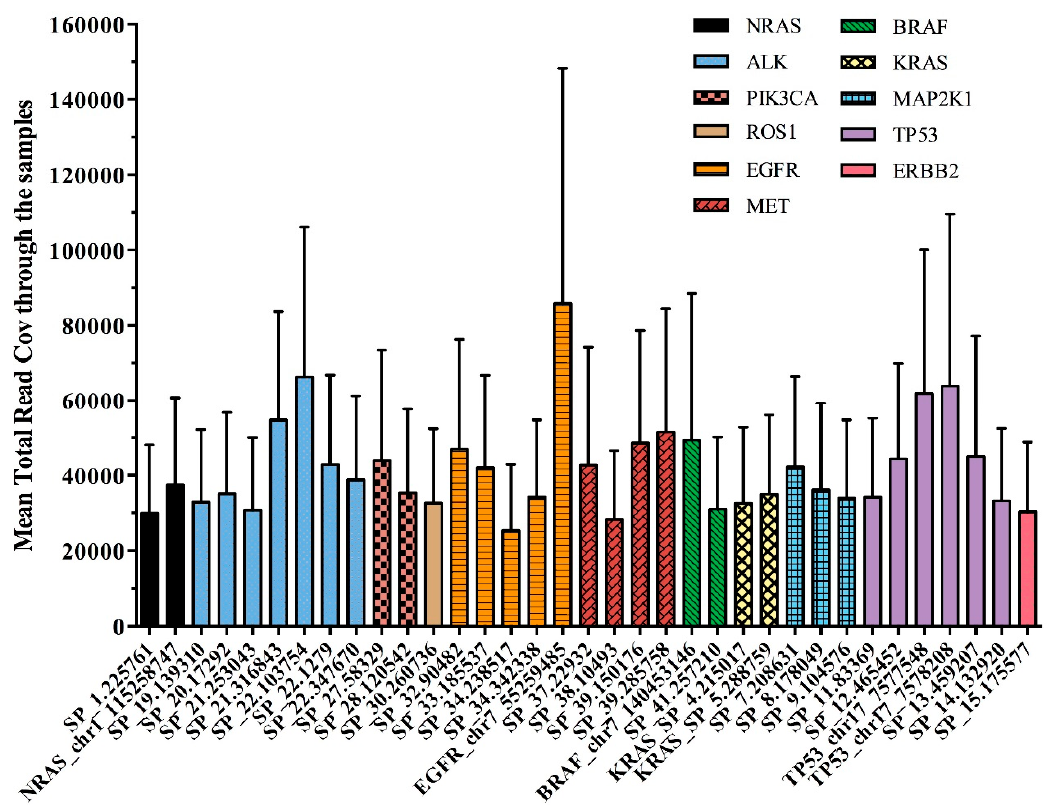
Figure 3. Assessment of the 35 amplicons of the OLcfA among the 92 samples tested. Mean total read coverage was investigated across all clinical samples tested (n = 92) and reported on y axis.